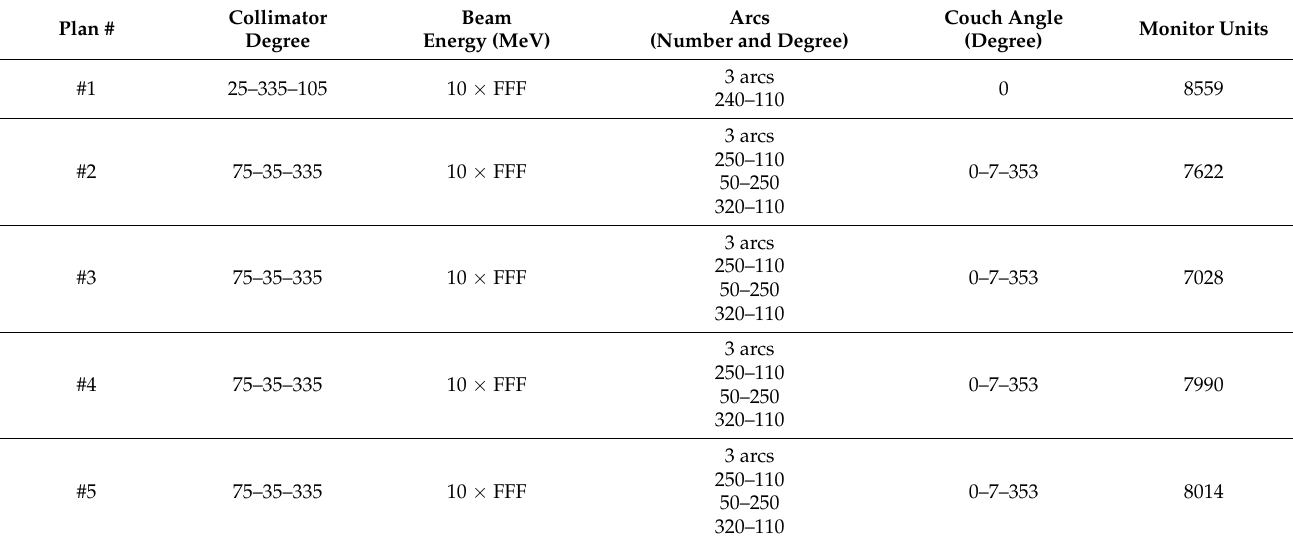
Table 2. Geometrical characteristics of STAR treatment